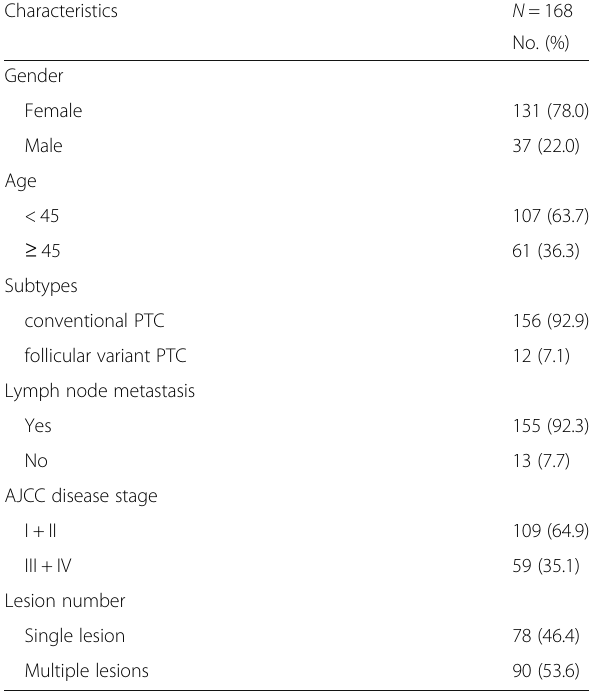
Table 1 Clinical characteristics of 168 PTC patients in southern Chinese populations Characteristics